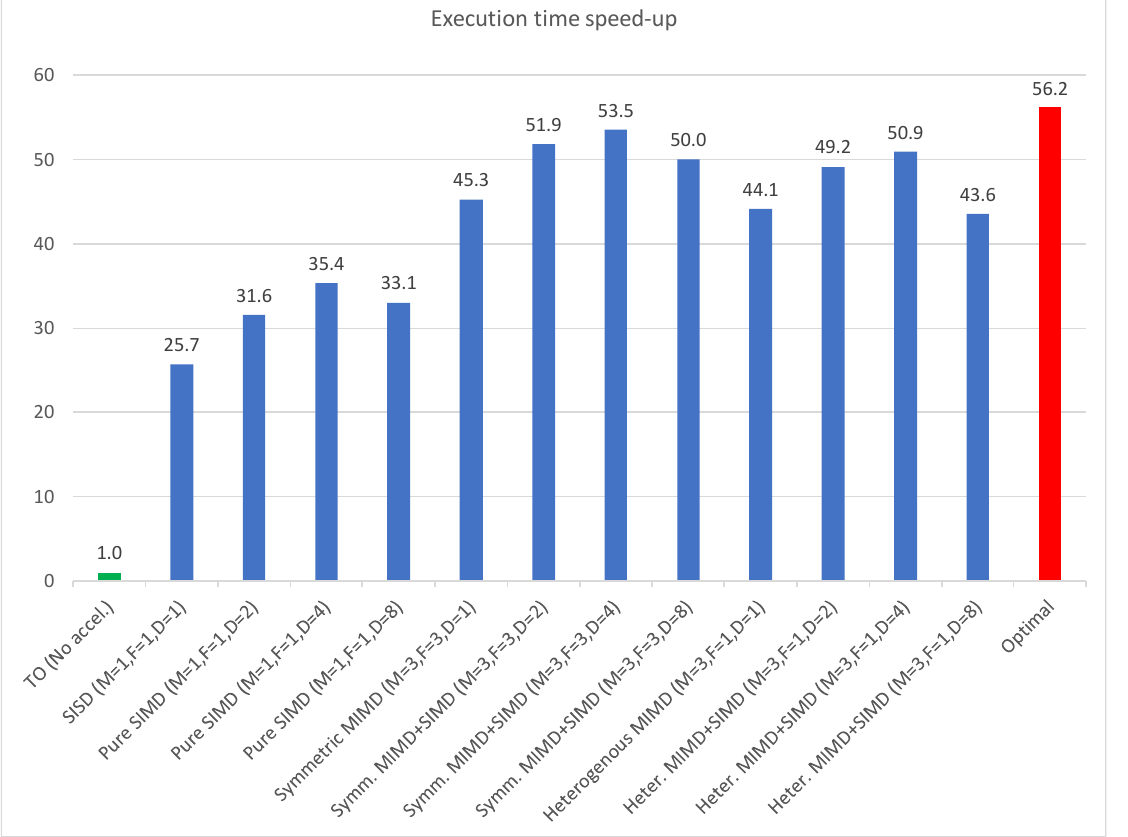
Figure 16. Total execution time speed-up over non-accelerated core obtained by each coprocessor configuration, along with